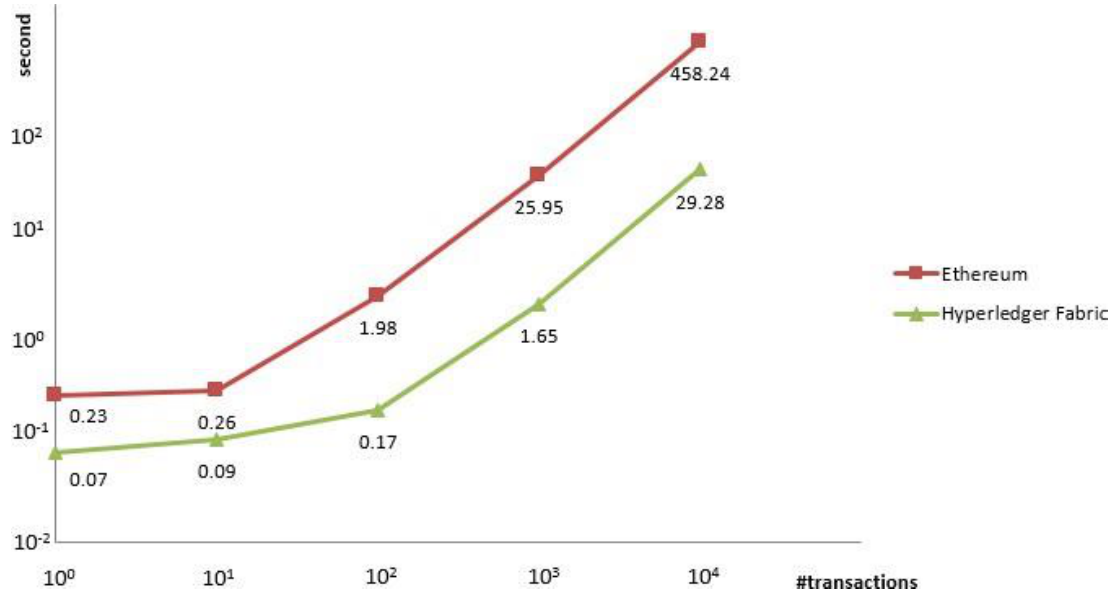
Figure 6. Comparison of enhanced Fabric with Ethereum.